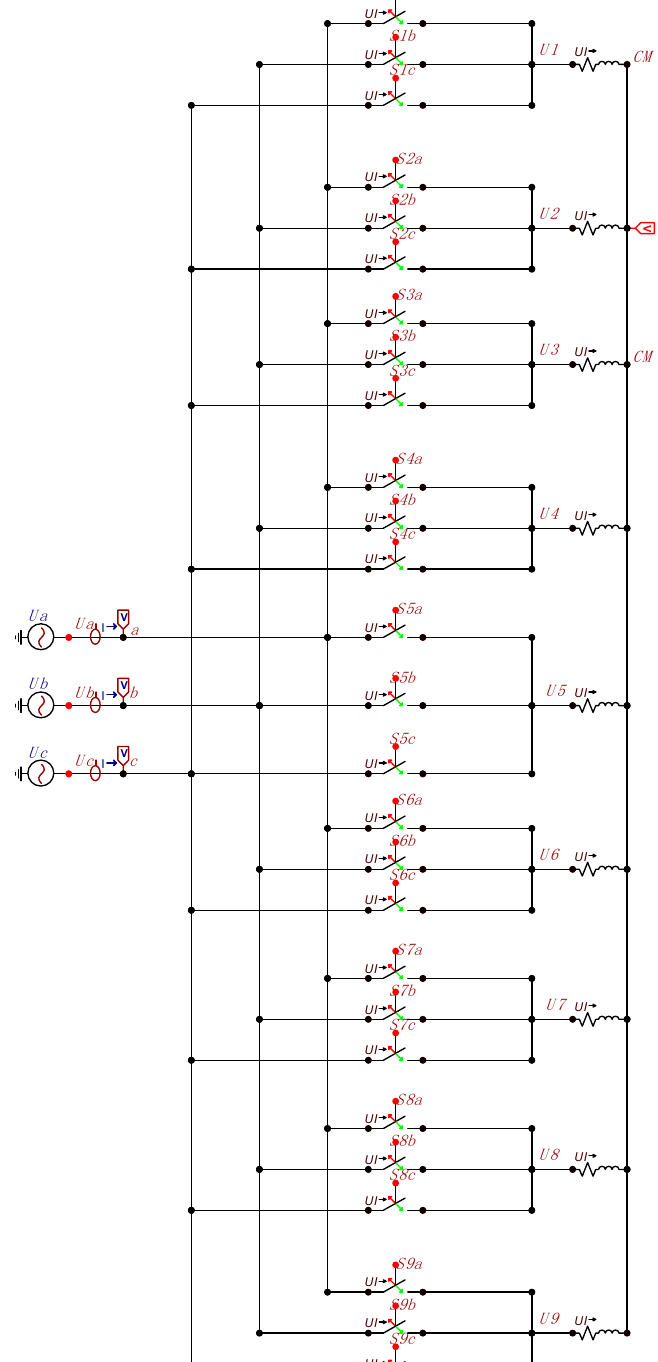
Figure 5. ATP simulation model of the three-to-nine-phase MC supplying nine-phase load. Input voltages are named Ua, Ub and Uc, output voltages are named from U1 to U9.